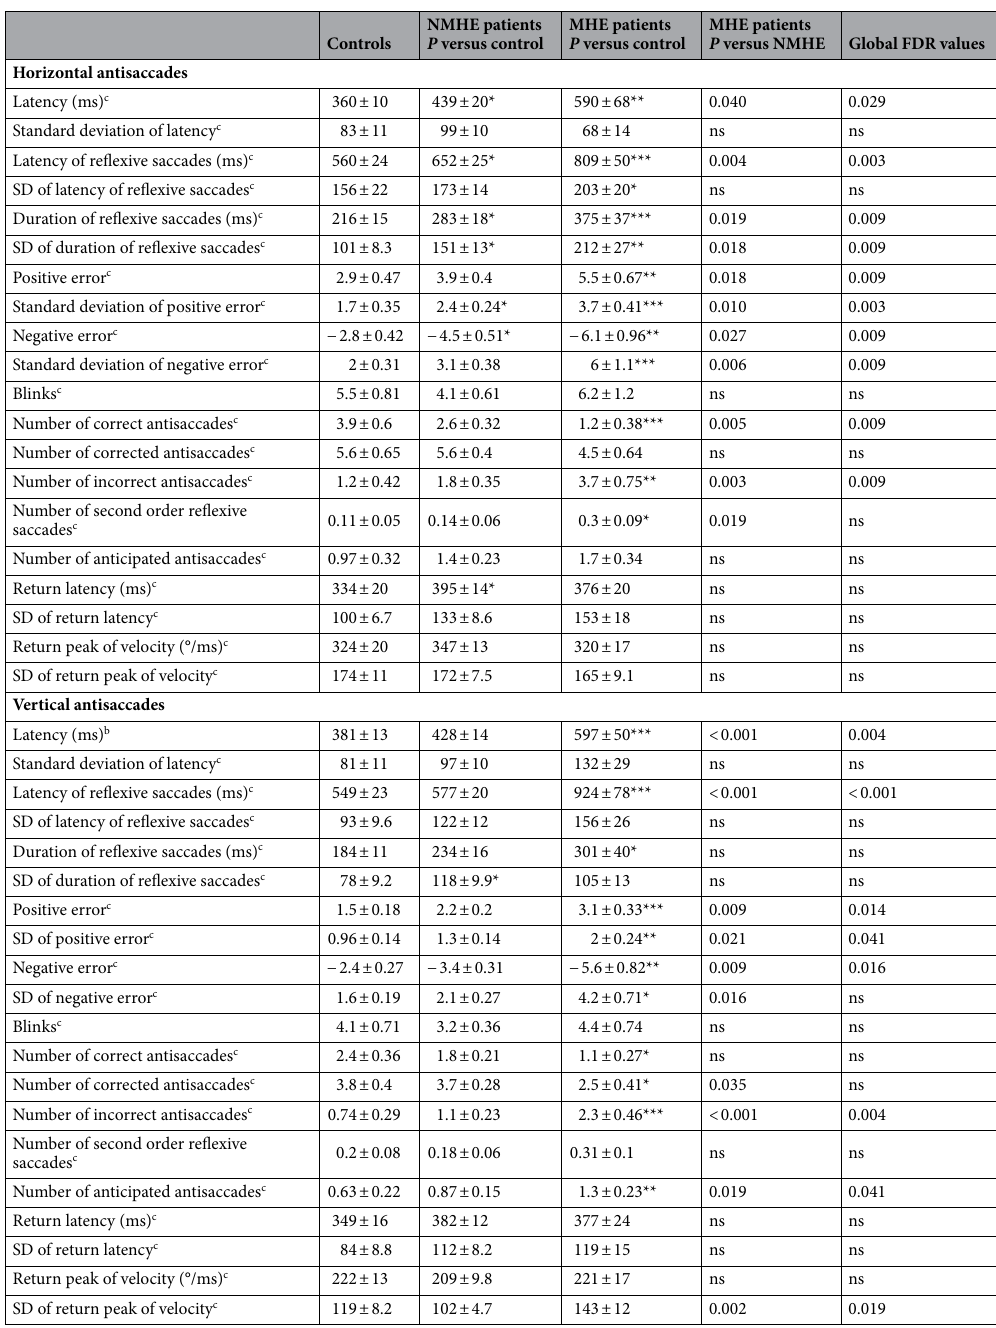
Table 2. Results of eye movement tests in the three groups of study. Horizontal and vertical antisaccades. All values are expressed as mean ± SEM. Abbreviations: NMHE and MHE, patients without and with minimal hepatic encephalopathy according to PHES; SD, Standard deviation. Differences between groups were analyzed using one of three possibilities: one-way ANOVA followed by Tukey’s multiple comparison test (a) parametric and homoscedastic variables, Welch’s ANOVA followed by Games-Howell’s multiple comparison test (b) for parametric but non-homoscedastic variables, and Kruskal–Wallis followed by Dunn’s multiple comparison test (c) for non-parametric variables. Significant differences compared to controls are indicated by asterisks: * p < 0.05; ** p < 0.01; *** p < 0.001; ns, non-significant. Detailed definitions of eye movement variables are in Supporting